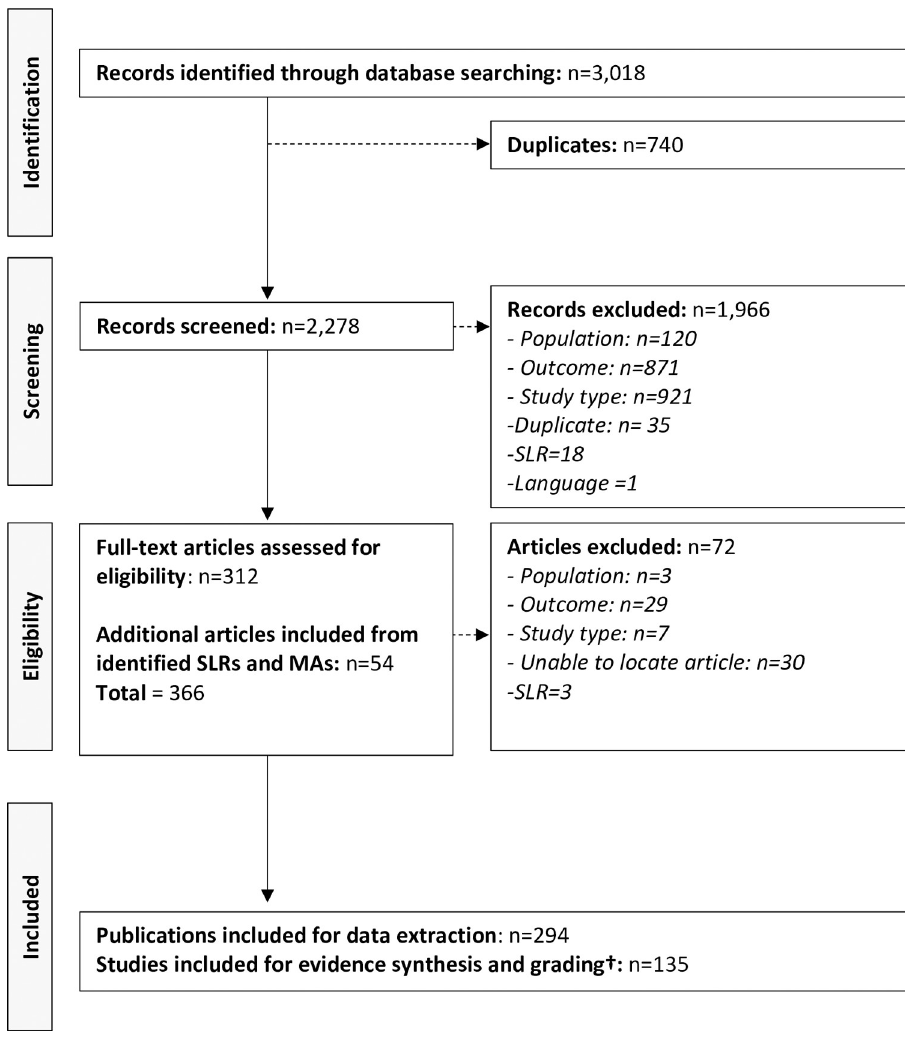
Fig 1. PRISMA diagram of the selection process of the included publications. Note: † Studies reporting evidence of statistically significant prognostic indicator of disease progression in DMD. Systematic literature reviews (SLRs). Meta- analyses